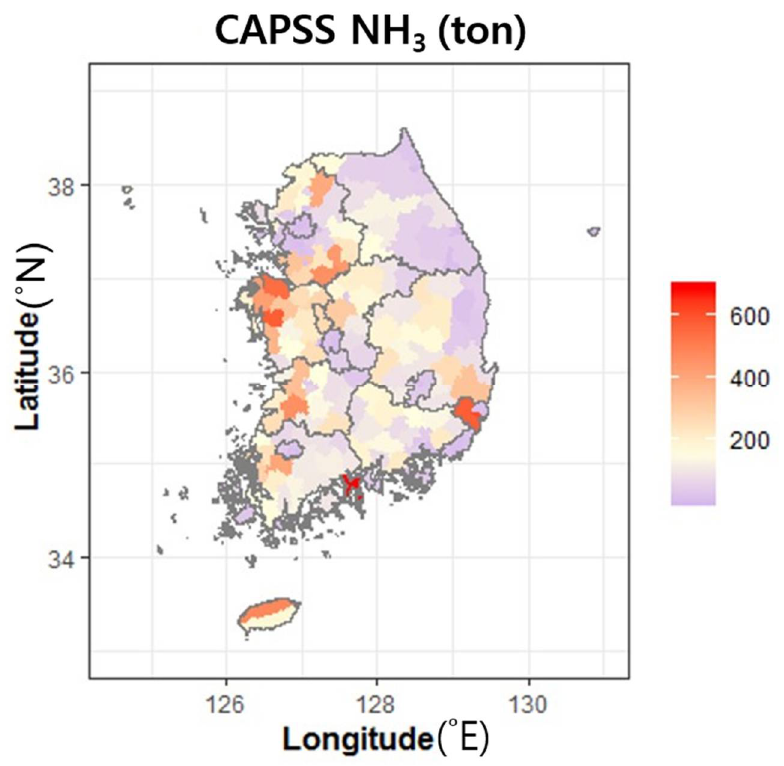
Figure 2. Annual ammonia emissions at local administrative levels in 2015, based on national emissions inventory (CAPSS, NIER, 2018).